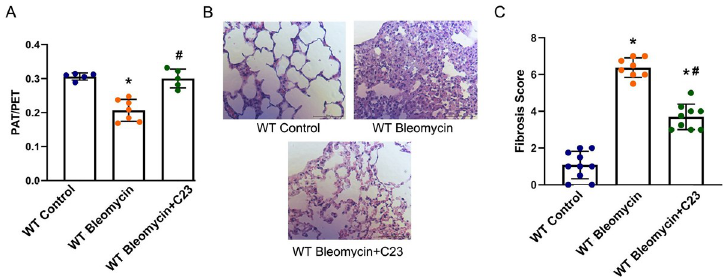
Fig 5. The eCIRP antagonist C23 ameliorates physiological markers of fibrosis in mice exposed to bleomycin. PAT/PET ratio ( A ) was calculated which correlates with inverse right ventricular pressure (a surrogate for pulmonary hypertension). 5- μ m lung tissue fragments preserved in paraffin and later stained with hematoxylin and eosin ( B ) were evaluated using Hu¨bner’s modification of the Ashcroft fibrosis score ( C ). Four random sites were observed and scored under light microscopy at 200x magnification; the mean score of four random sites was used as the fibrosis score of each lung section. The representative sample for the lung sections is shown at 400x from Wild Type (WT) Control, WT Bleomycin, and WT Bleomycin+C23 mice ( B ). � p < 0.05 vs. WT Control, # p < 0.05 vs. WT Bleomycin. WT Bleomycin and WT Control groups are identical to that of Fig 3.